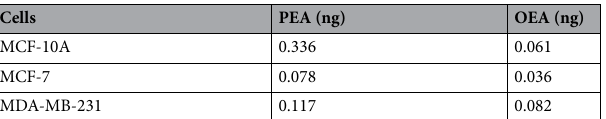
Table 1. Endocannabinoid levels of PEA and OEA determined for breast cancer cells. Endocannabinoid levels of PEA and OEA determined for breast cancer cells. Values are in ng/10 6 cells.